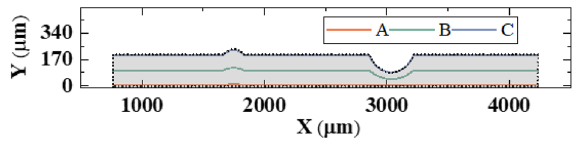
Figure 4. The three curves A, B and C in